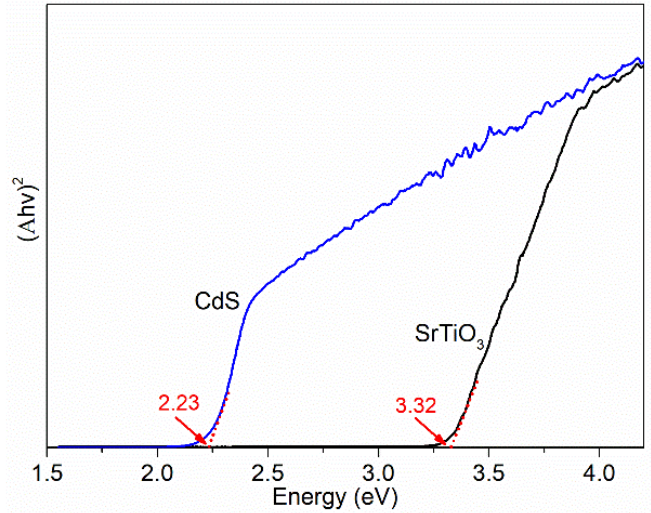
Figure 11. Band gaps of SrTiO 3 and CdS.